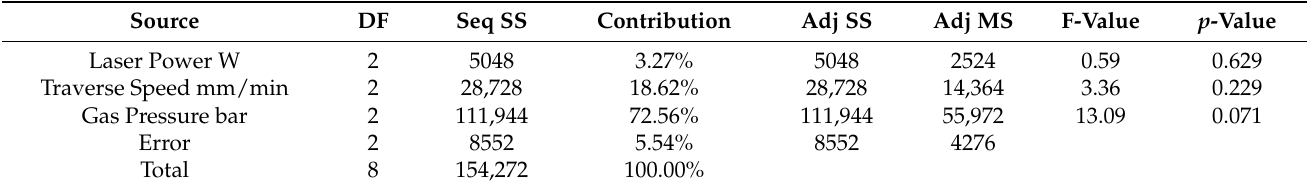
Table 6. ANOVA table for HAZ response of input cutting parameters of 2 mm thick SPF-UPE.